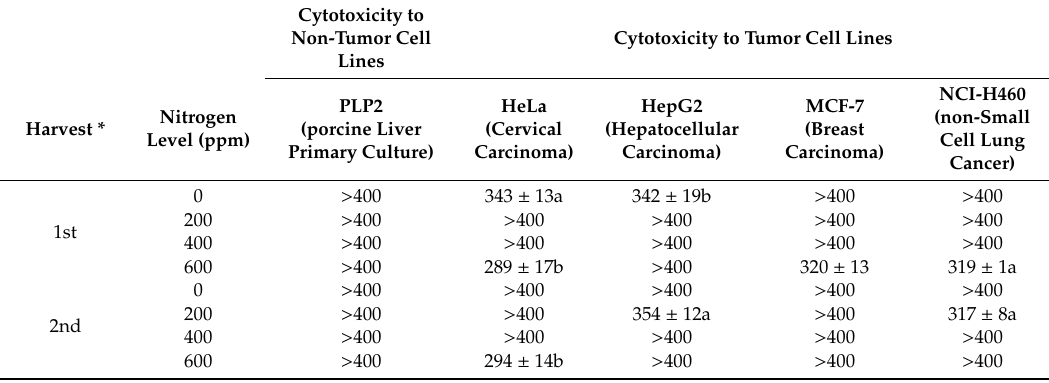
Table 10. Cytotoxicity and antitumor activity (GI 50 values µ g / mL) of Centaurea raphanina subsp. mixta plants grown in 2 L pots under greenhouse conditions, in relation to harvesting time (1st and 2nd harvest) and nitrogen level (0–600 ppm) (mean ± SD; n =